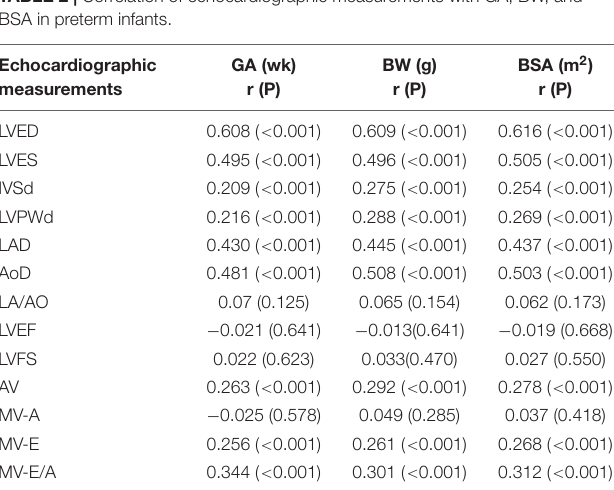
TABLE 2 | Correlation of echocardiographic measurements with GA, BW, and BSA in preterm infants. Echocardiographic measurements